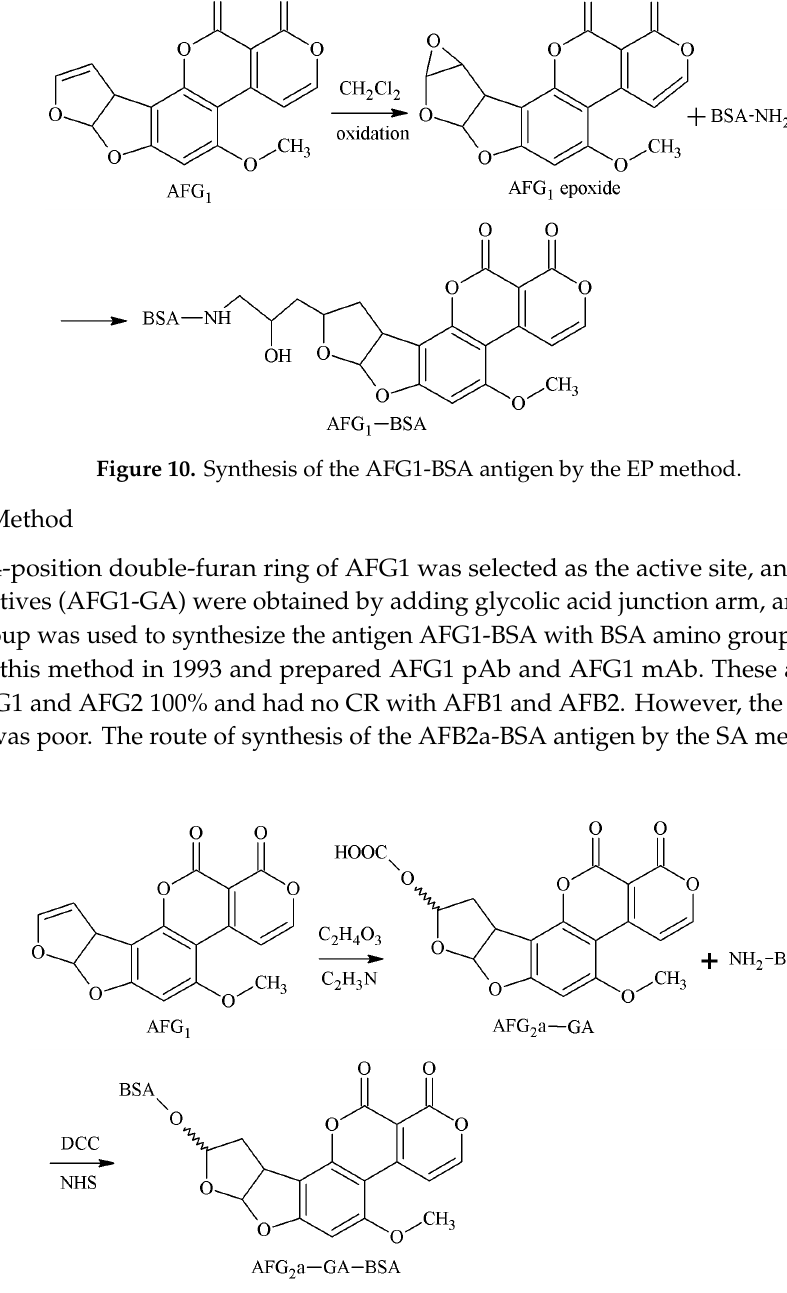
8 of 16 Figure 9. Synthesis of the AFG2a-BSA antigen via the SA method. 2.2.2. EP Method The 3-4-position double-furan ring of AFG1 was selected as the active site. Under the oxidative action, the 3-4-position double-furan ring formed an epoxide that reacted with the amino groups of the carrier proteins to form secondary amines, and the antigen AFG1-BSA was synthesized via a